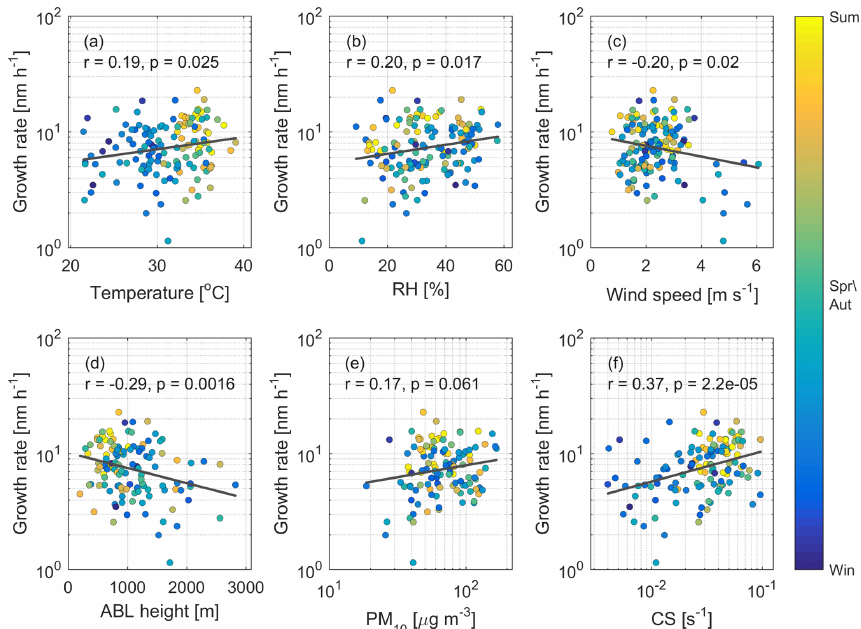
Figure A4. Particle growth rate (GR 7 − 12nm ) as a function of (a) temperature, (b) relative humidity, (c) wind speed, (d) atmospheric boundary layer height, (e) PM 10 and (f) the condensation sink. The black lines show the least squares fits to the log-linear ( a, b, c, d ) or log–log ( e and f ) data, and the r and p values denote the Pearson correlation coefficients and their significance levels, respectively. The values on the horizontal axis are event-time averages (from NPF start to NPF end; see Fig. 1). In the case of the CS, the averaging was done for 1h before the NPF start to make sure that the correlation is not influenced by the particles formed in the NPF event itself. The data are colored according to the season, so that summertime is represented by yellow and wintertime by blue